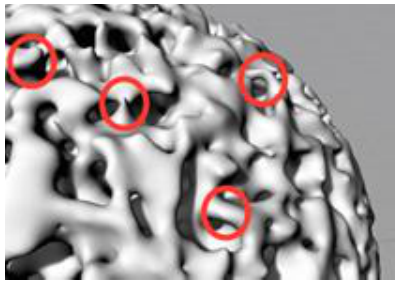
Figure 1. Trabecular structure with thin walls.